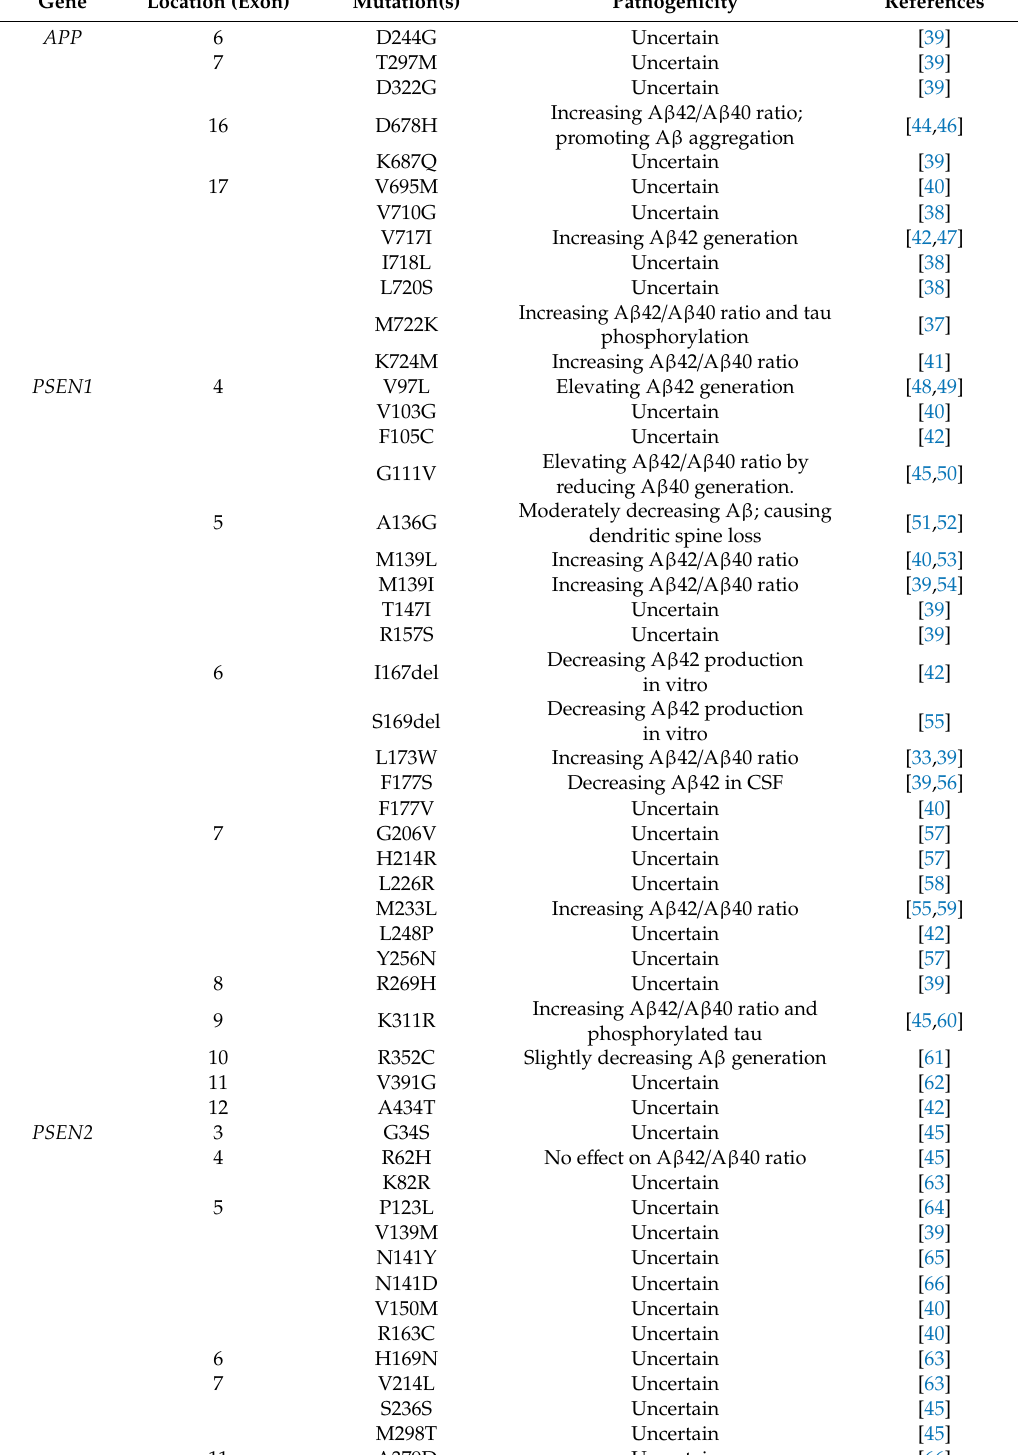
Table 1. Mutations in APP , PSEN1 , and PSEN2 as reported in Chinese population.